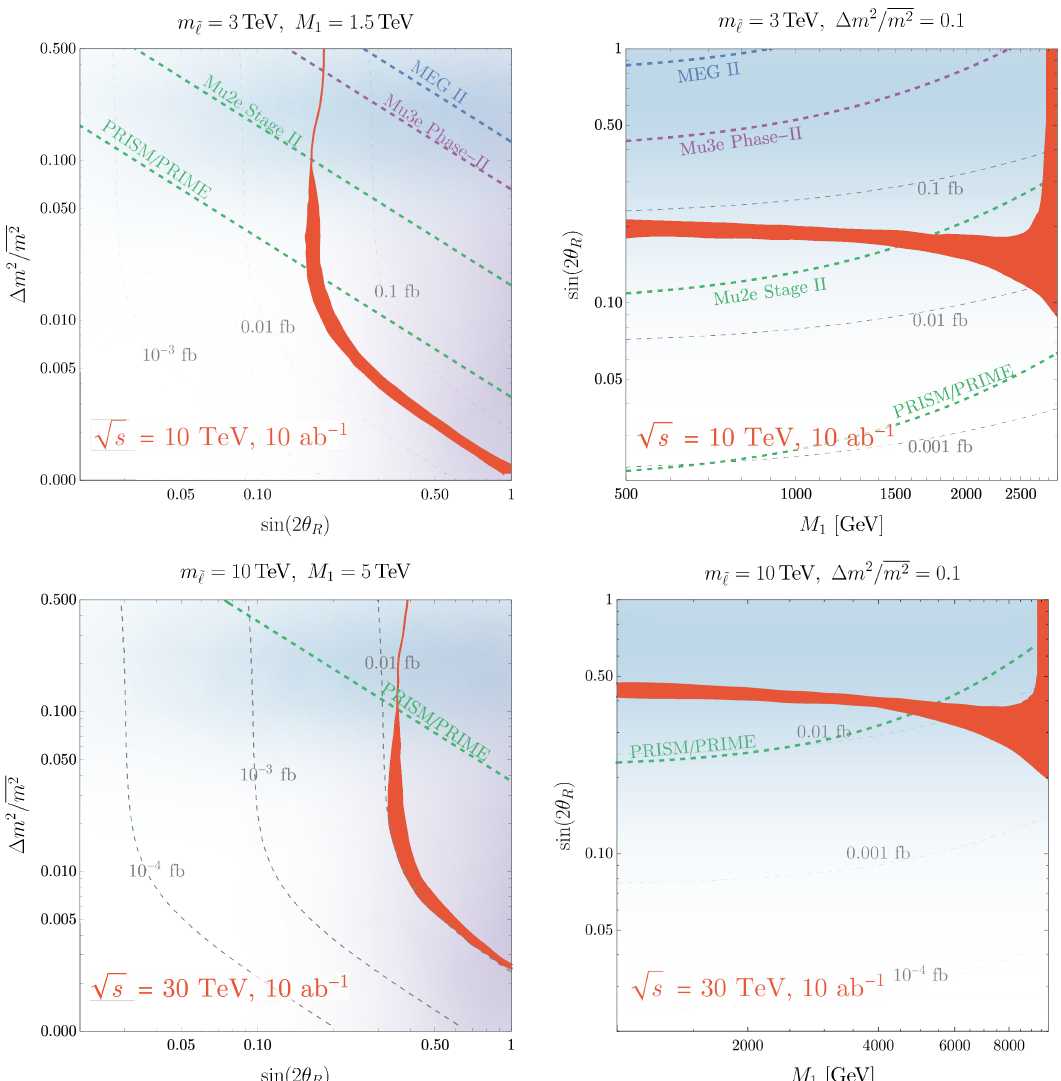
Figure 6. 5 σ discovery reach of lepton-flavor violating MSSM from a 10 TeV (top) or 30 TeV (bottom) muon collider, both with 1 ab − 1 of data, in ∆ m 2 /m 2 vs sin 2 θ R plane and sin 2 θ R vs M 1 plane (red band). The width of the collider reach band shows the uncertainty due to inexact slepton and neutralino mass measurements. The gray contours are cross sections of the signal process. The expected limits from low-energy lepton flavor violation experiments are indicated by the blue, purple and green dashed lines. The purple and blue shaded lightly shaded regions indicate parameters preferred in Gauge-Mediated Supersymmetry Breaking scenarios and flavor-dependent mediator scenarios,